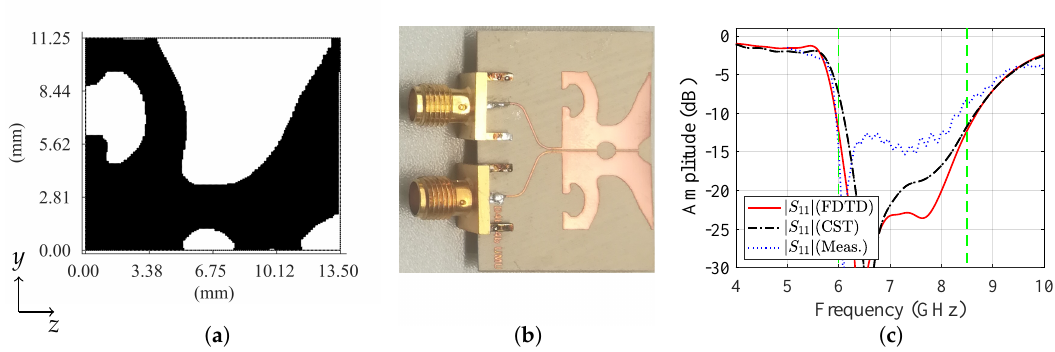
Figure 7. Antenna II: ( a ) The shape of the antenna optimized to radiate over the frequency band 6.0–8.5 GHz and to filter the frequencies 3.5–6.0GHz and 8.5–11.0GHz. ( b ) Photo of a manufactured prototype. ( c ) The measured and computed antenna reflection coefficient. The operational band is marked by the green dashed